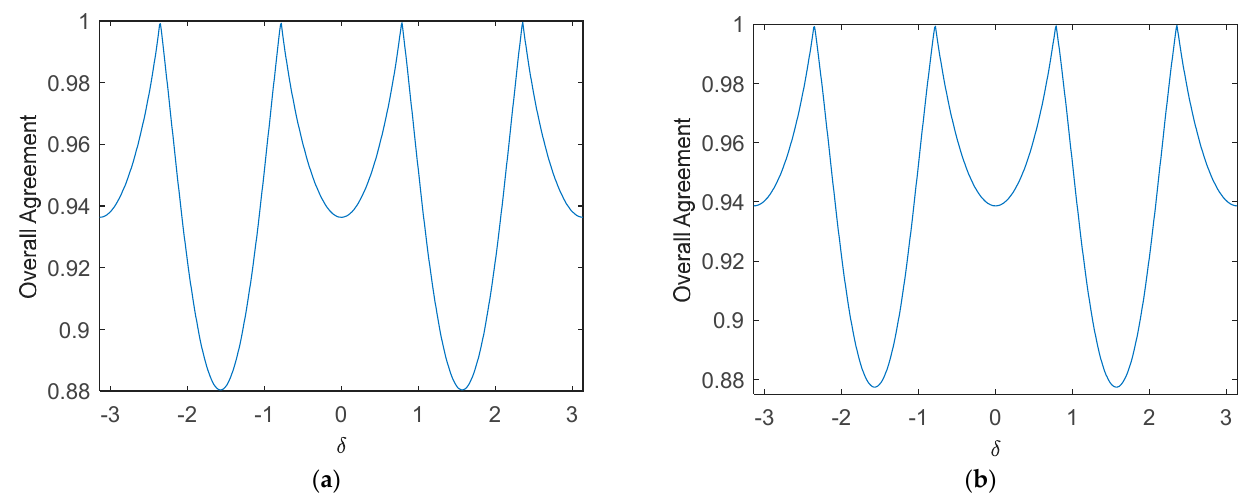
(cid:0) (cid:0) (cid:104) (cid:105) (cid:1)(cid:1) with the relative phase of S HH S ∗ Re VV